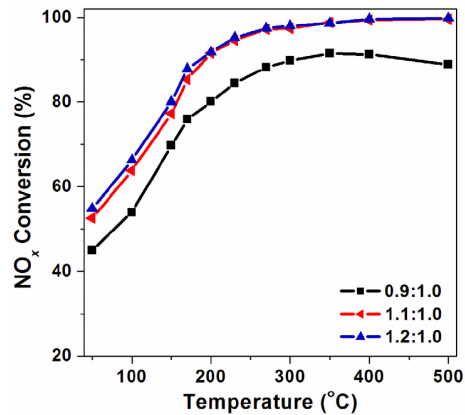
Figure 5. Influence of different NH 3 /NO ratios on NO x conversion over Fe0.5 ‐ W ‐ Ce catalyst. Reaction conditions: [NH 3 ] = 450 ppm, 2.5% O 2 , N 2 as balance, GHSV = 20,000 h − 1 .